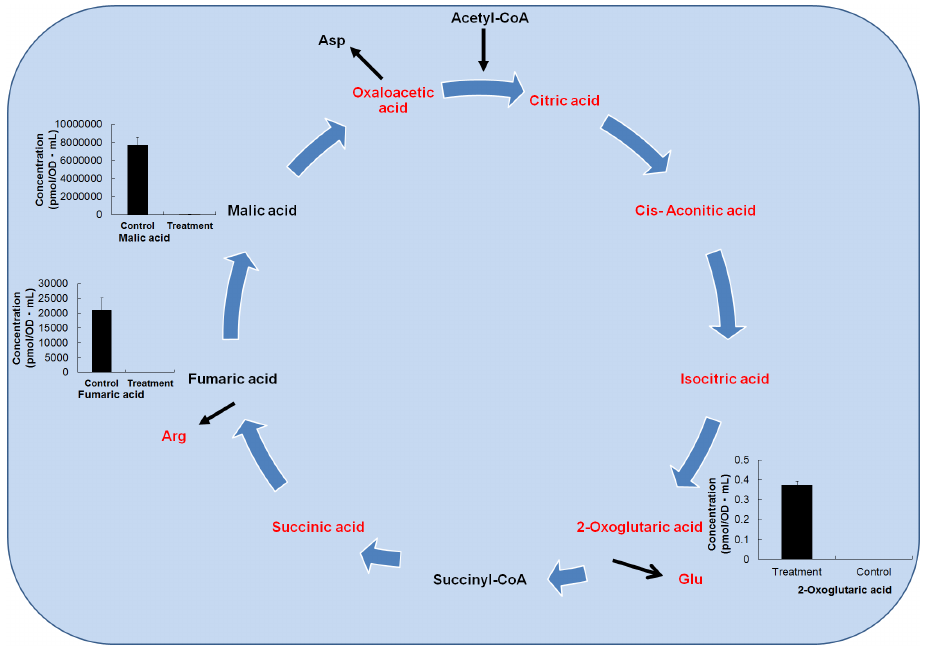
Fig 5. Alteration of the metabolites in the TCA cycle by fermentation. The metabolitelevels in TCA cycle in in the fermented O . japonicus by L . plantarum (gray bars) comparedwith those in the O . japonicus with L . plantarum (black bars) obtained by capillaryelectrophoresis time of flight mass spectrometry (CE-TOF-MS). The error bar indicatesthe mean standard deviationof triplicate samples.The figure also includesa schematic diagram of the TCA cycle.